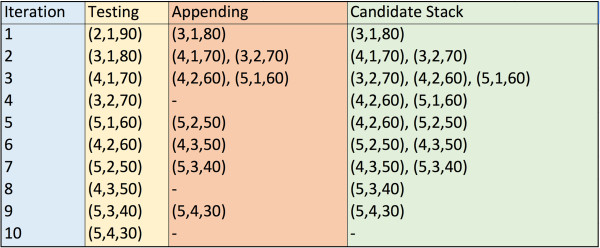
Algorithm execution example. This figure refers to the data in Figure 2. The first index, i, represents the row and the second index, j, represents the column. The third index, s, represents the total number of mutations at amino acids i and j. Beginning in position (2,1,90), we then add (3,1,80) to the stack, then {(4,1,70), (3,2,70)} and so forth. After each addition to the stack, we pick the element with the highest value in the third position of the 3-tuple.